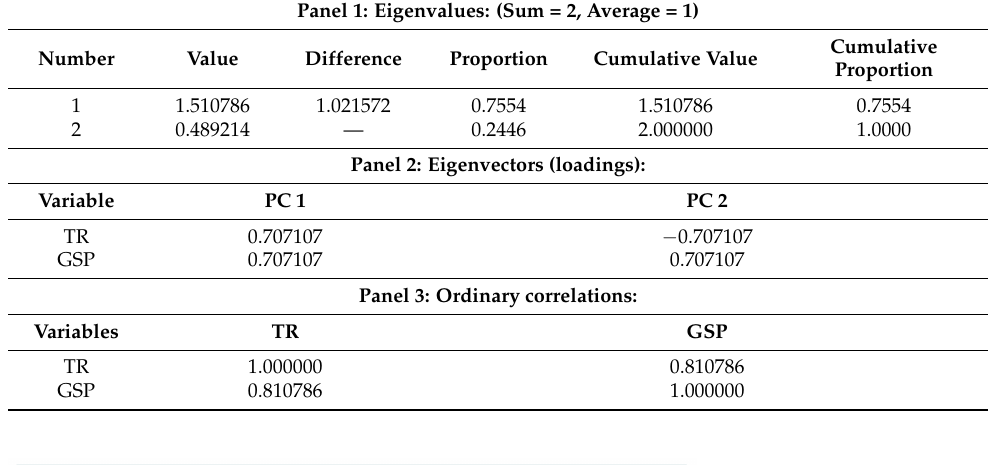
Table 2. Principal component analysis.